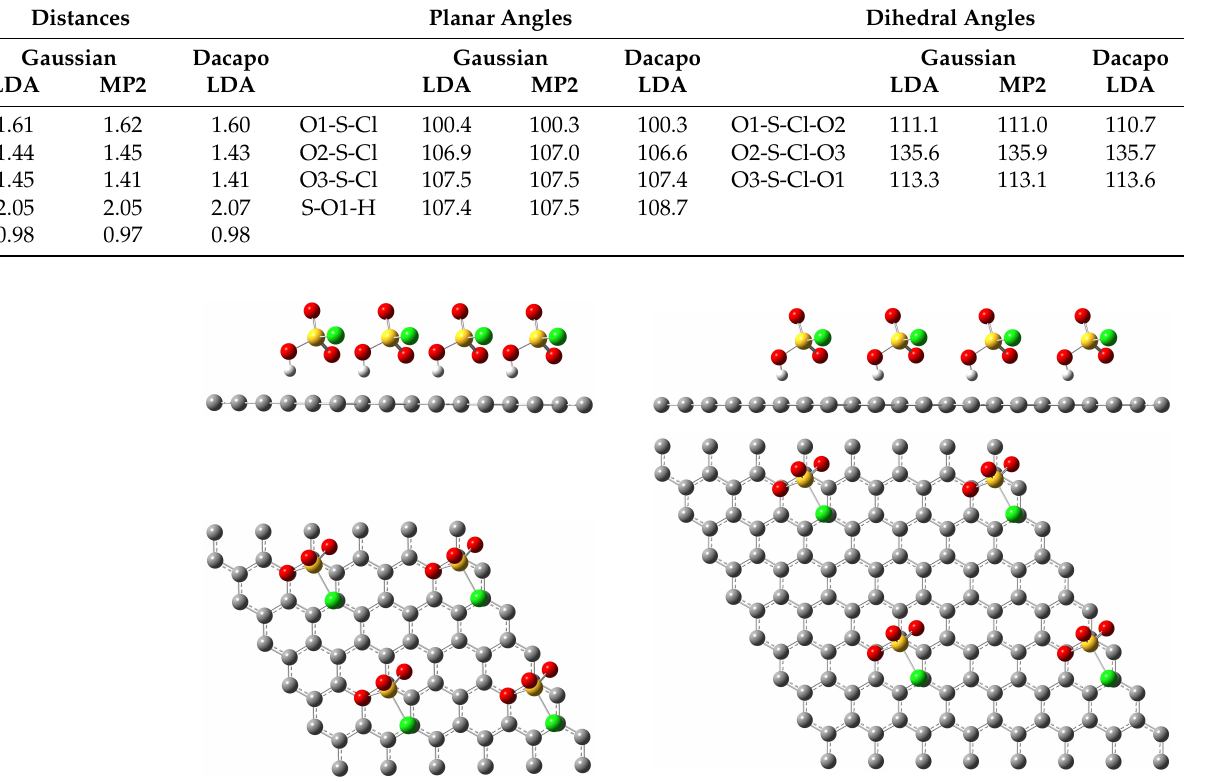
Figure 3. Side ( upper row ) and front ( lower row ) views of 2 × 2 unit cells of chlorosulfonic acid adsorbed on graphene for two concentrations: high ( left panels ) and low ( right panels